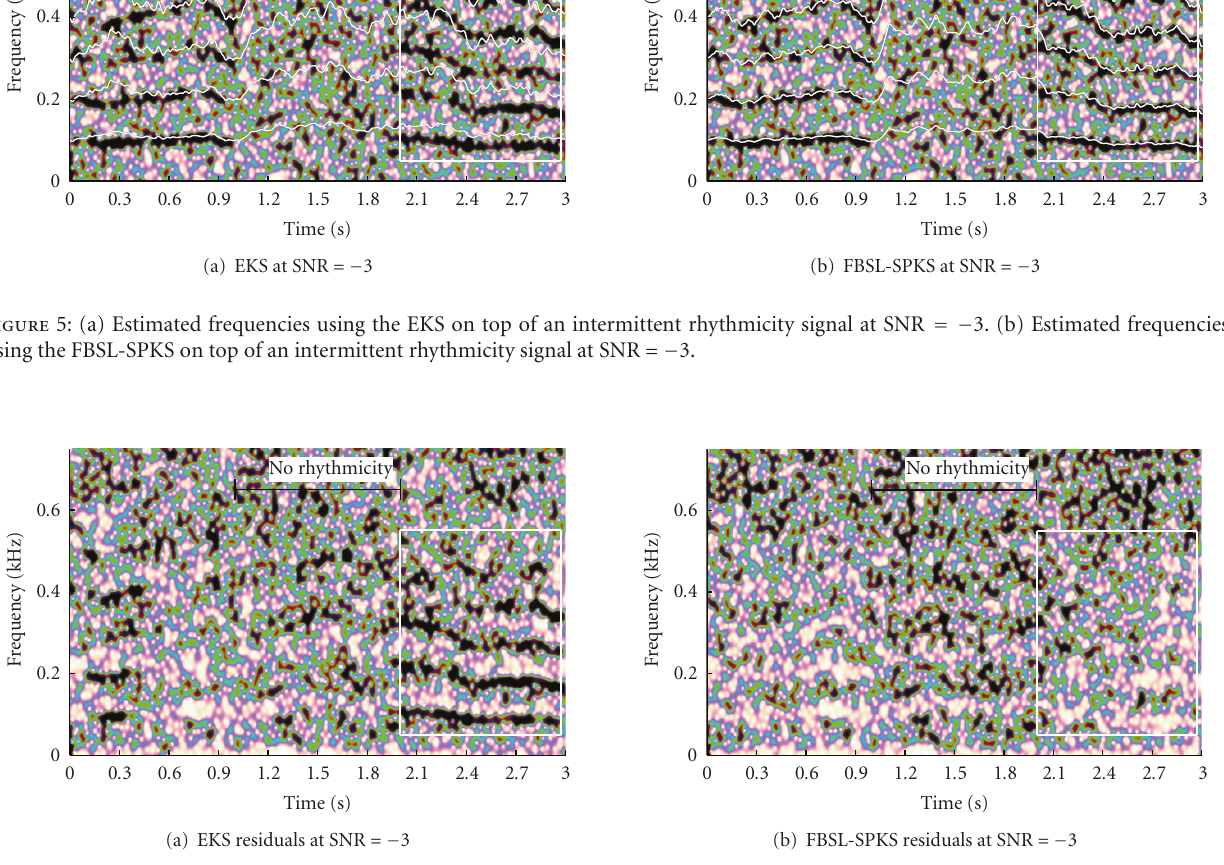
Figure 6: (a) Spectrogram of a residual signal using the EKS tracking of an intermittent rhythmical signal. (b) Spectrogram of a residual signal using the FBSL-SPKS tracking of an intermittent rhythmical signal.